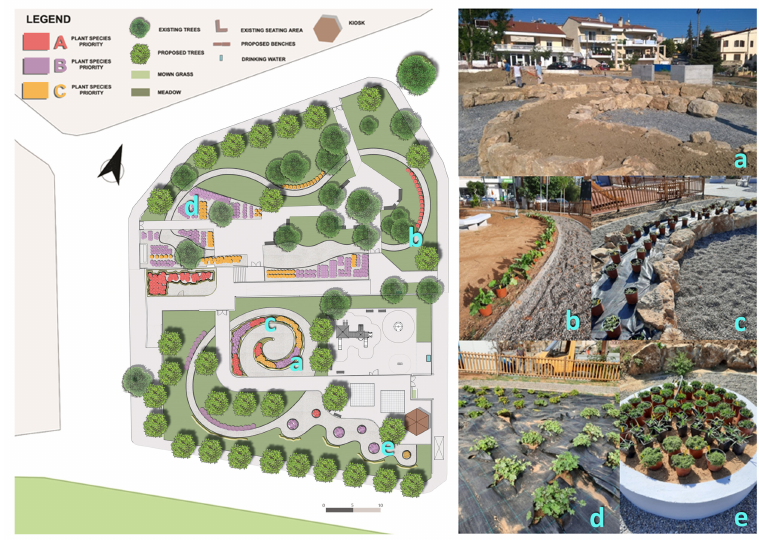
Figure 10. Masterplan of the Botanical Awareness Public Park (BAPP) in Kardia, Munipalicity of Thermi, metropolitan Thessaloniki, Northern Greece. ( a ) Rock formation of the spiral garden for the exhibit of the aromatic-pharmaceutical section (August 2020); ( b ) planting on the ground of Rumex balcanicus (Priority A1); ( c ) Planting the spiral garden (September 2020); ( d ) Planting on geotextile Alchemilla serbica (Priority B4); ( e ) planting of three different local Balkan priority plants in circular raised concrete beds in September